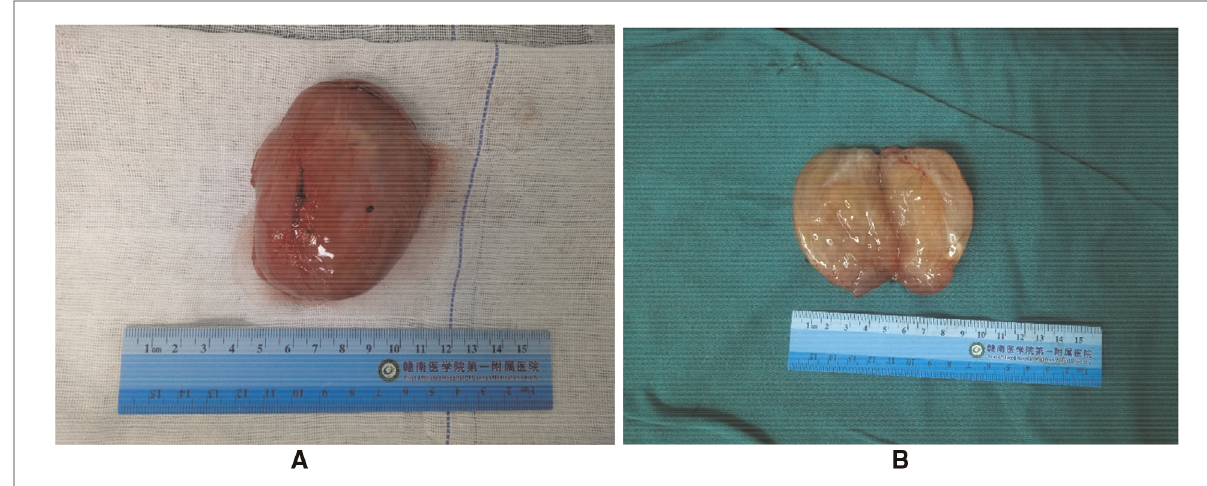
FIGURE 2 Patient tumor specimen. ( A ) The excised specimen was approximately 8.5 cm×6 cm×5 cm with clear margins. ( B ) The surface is grayish white, jelly- like,